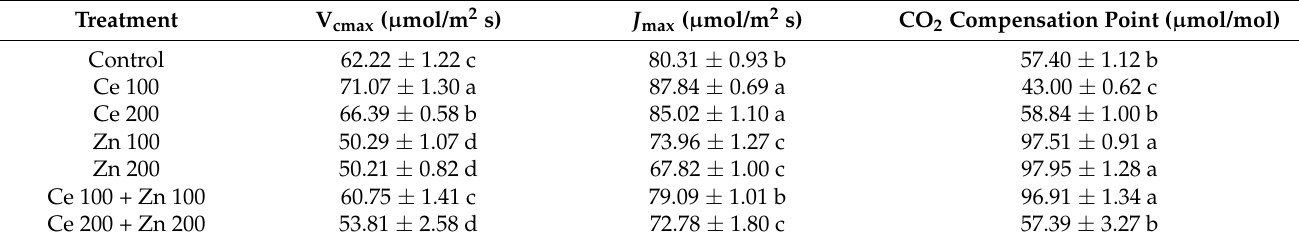
Table 2. Maximum ribulose 1,5-bisphosphate carboxylation rates (V cmax ), maximum electron transport rates ( J max ) and CO 2 compensation points determined for Pisum sativum L. plants grown under the sole or combined CeO 2 and ZnO NPs treatments. Distinct letters show the statistically significant differences among treatments as calculated with Tukey’s HSD post hoc test ( p = 0.95), n =